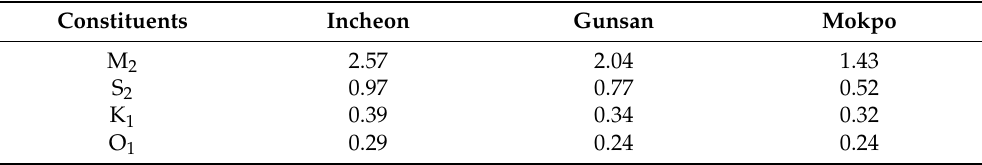
Figure 3. Simplified basin ( a ) for sensitivity tests, ( b ) bathymetry shapes at near the coast, and ( c ) x -directional maximum velocities along transect AA (cid:48) . Table 1. Tidal amplitude (m) applied at an open boundary representing macro-tidal and meso-tidal environments for a simplified